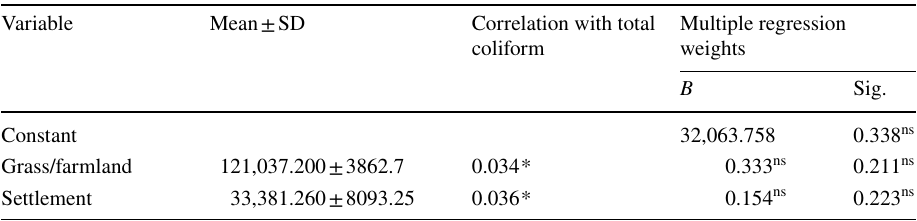
Table 5 Correlation and multiple linear regression analyses between total coliform and